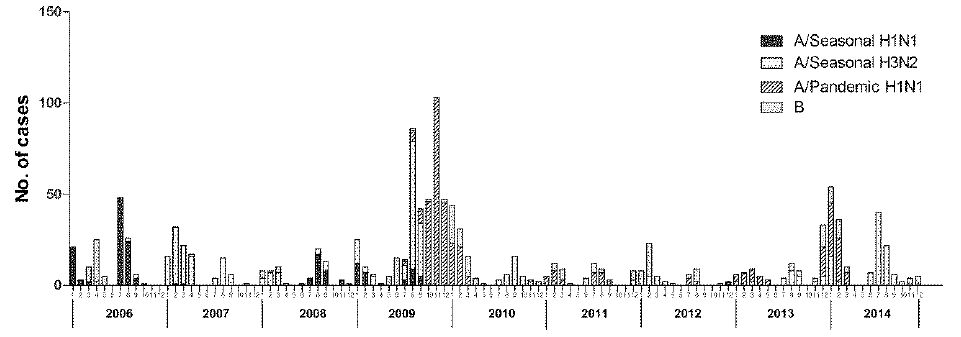
Figure 2. Time distribution of influenza subtypes in Ningbo, China, 2006–2014.